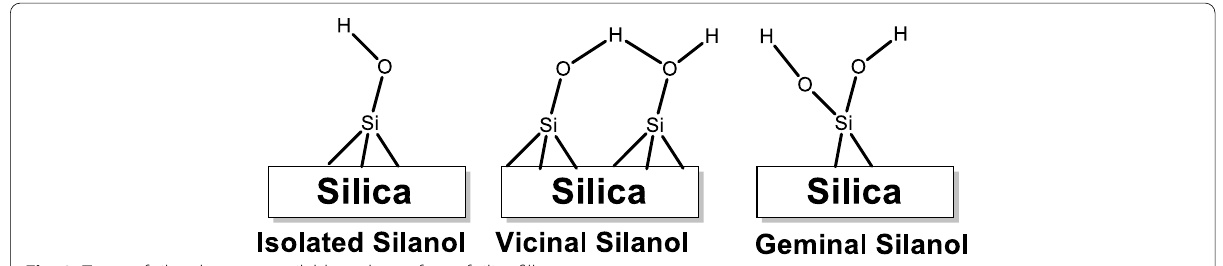
Fig. 8 Types of silanol groups available at the surface of silica